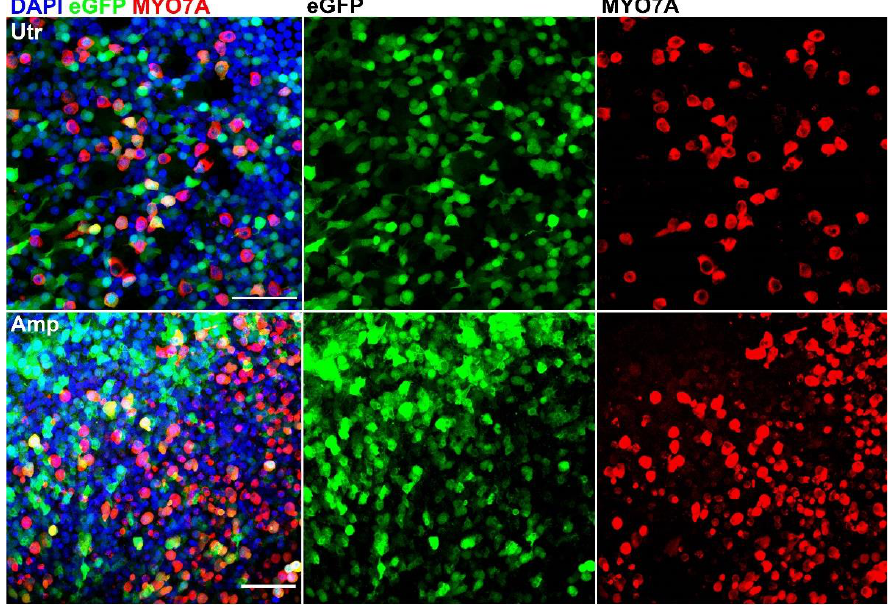
Figure 5. Details of transduced adult utricle (Utr) and ampulla (Amp), immunostained with anti- MYO7A antibodies. Cell counts were carried out on data from 2 ampullas and 3 utricles. Scale bars apply to all images in each row: 50 µm.